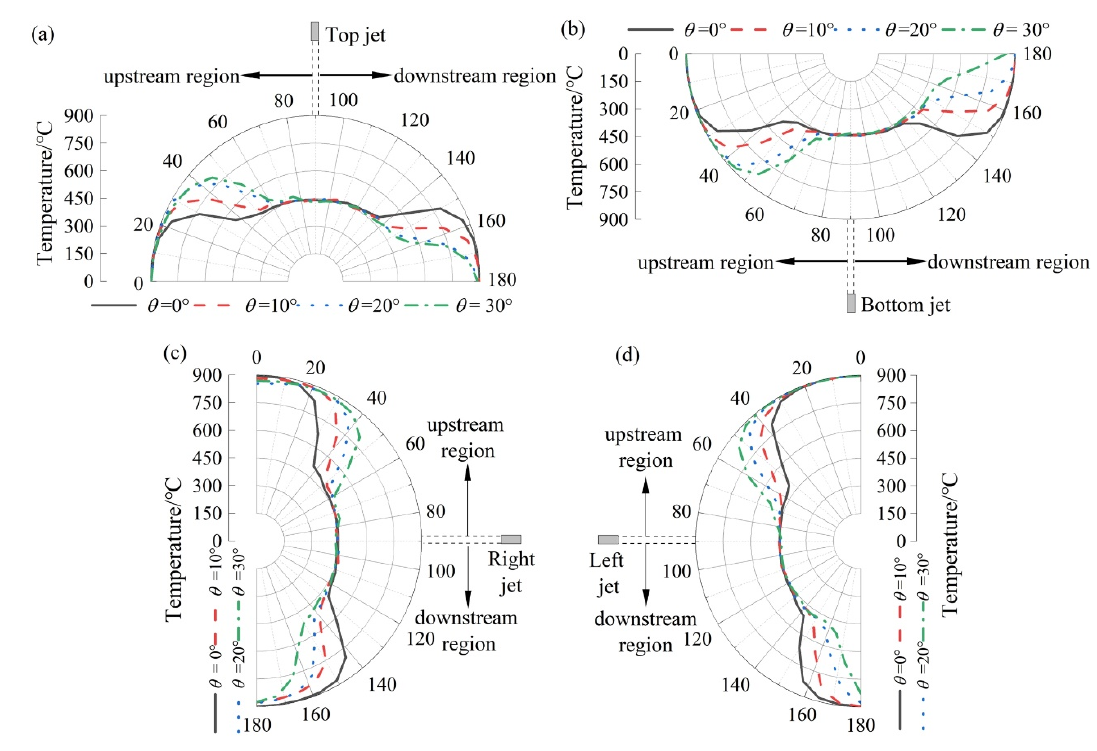
tom jet; ( c ) right jet; ( d ) left jet. jet; ( c ) right jet; ( d ) left jet.